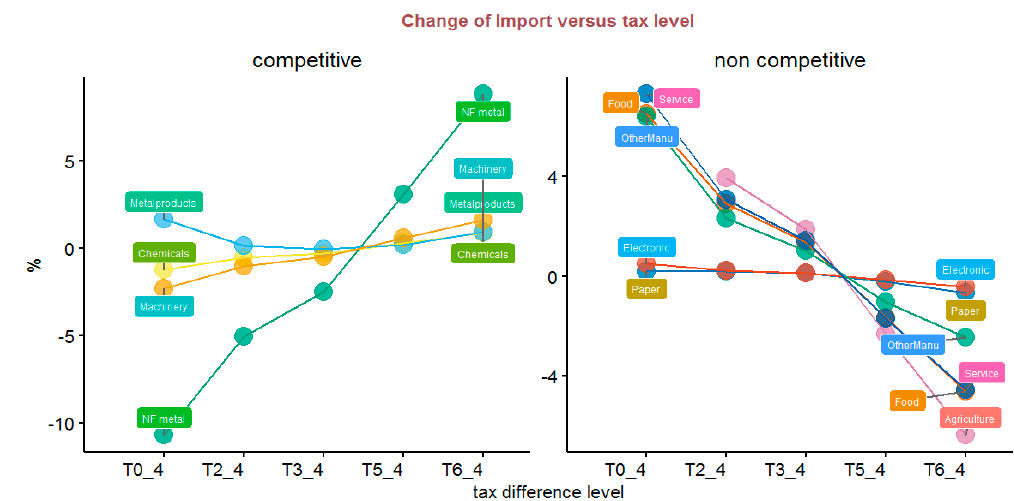
Figure 9. Import change compared with T4_4 of Guangdong Province in 2030.